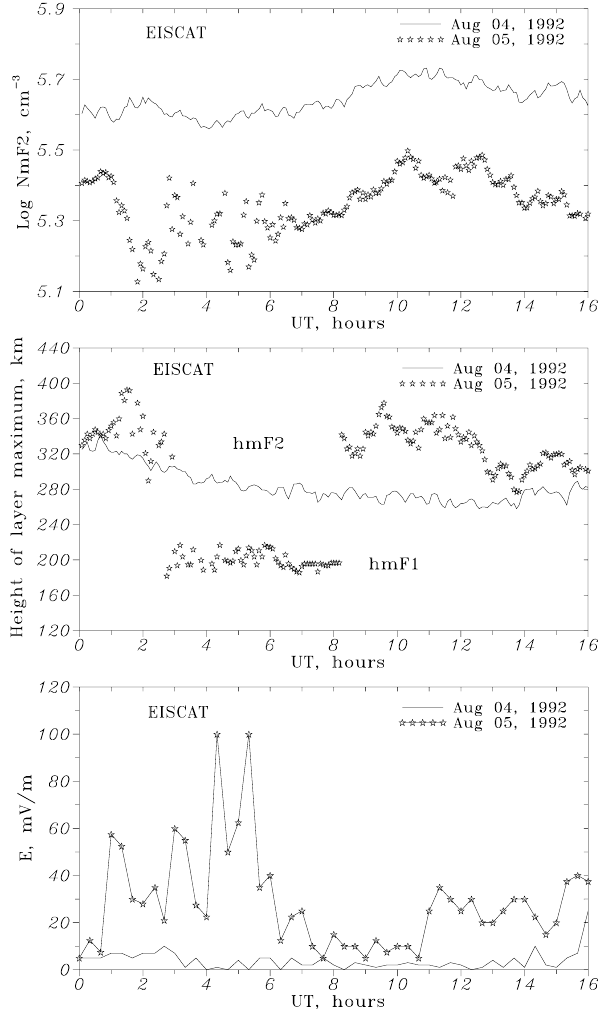
Fig. 6. Observed with EISCAT diurnal variations of NmF2, hm F2 and electric fields for quiet 04 August 1992 and disturbed 05 August 1992 days. Note the decrease in the height of the layer maximum after a strong electric field is switched on.